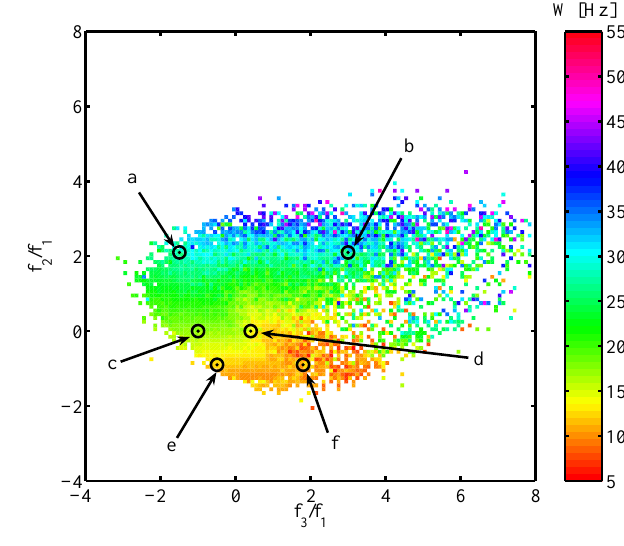
Fig. 5. Histogram of the number of radar echoes versus the f 2 /f 1 ratio and the Doppler spectral width W (in Hz). The number of echoes is colour coded on a logarithmic scale. This histogram was built using 80 2 equispaced bins.